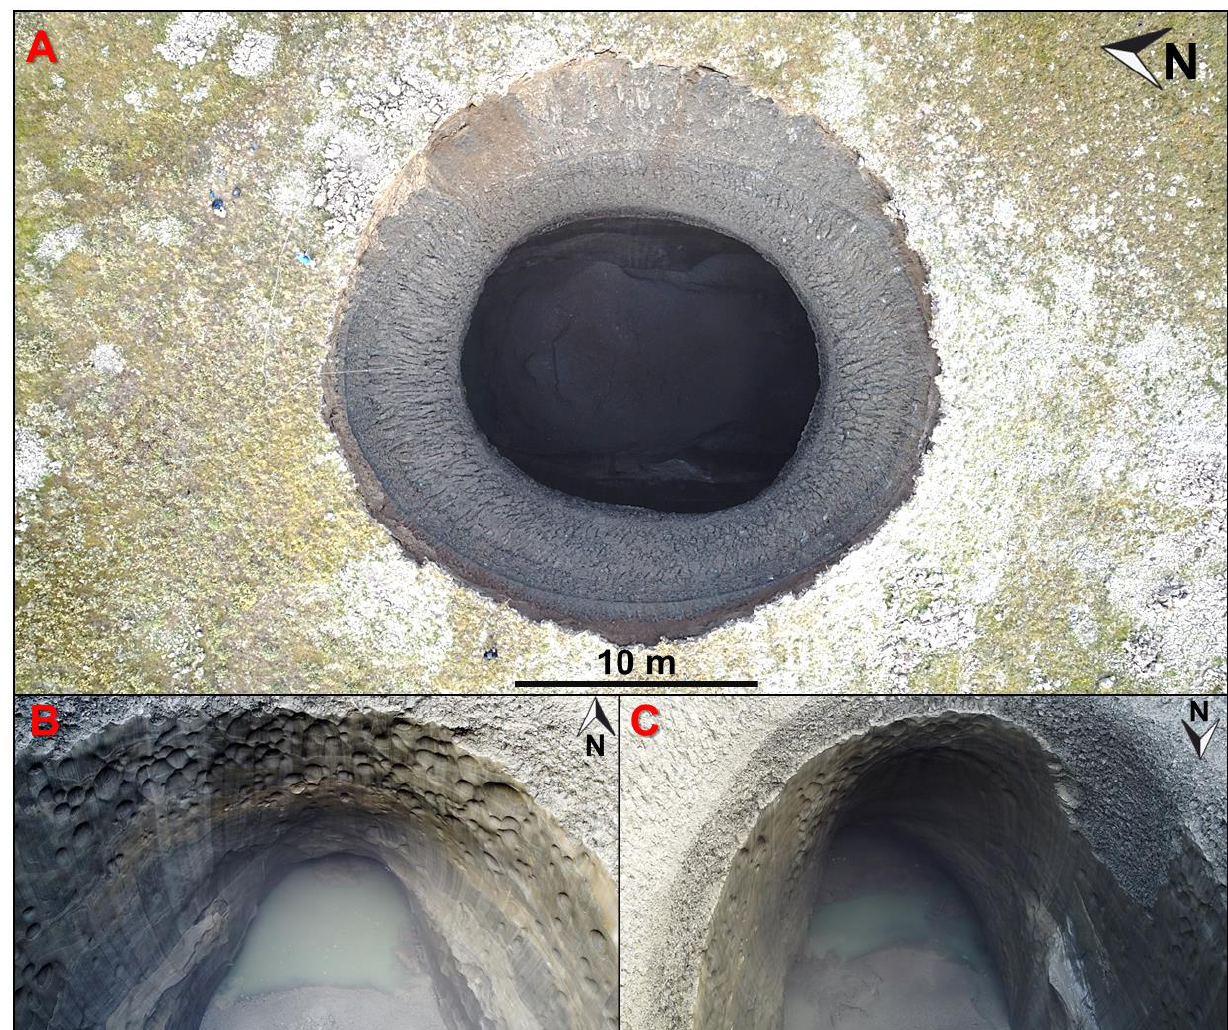
Figure 5. Aerial photographs of the C17 crater from the height of 50 m above sea level ( A ), its northern ( B ) and southern ( C ) grottoes from inside the crater (photo from unmanned aerial vehicle (UAV) taken by certified external pilot Igor Bogoyavlensky, August 26, 2020).